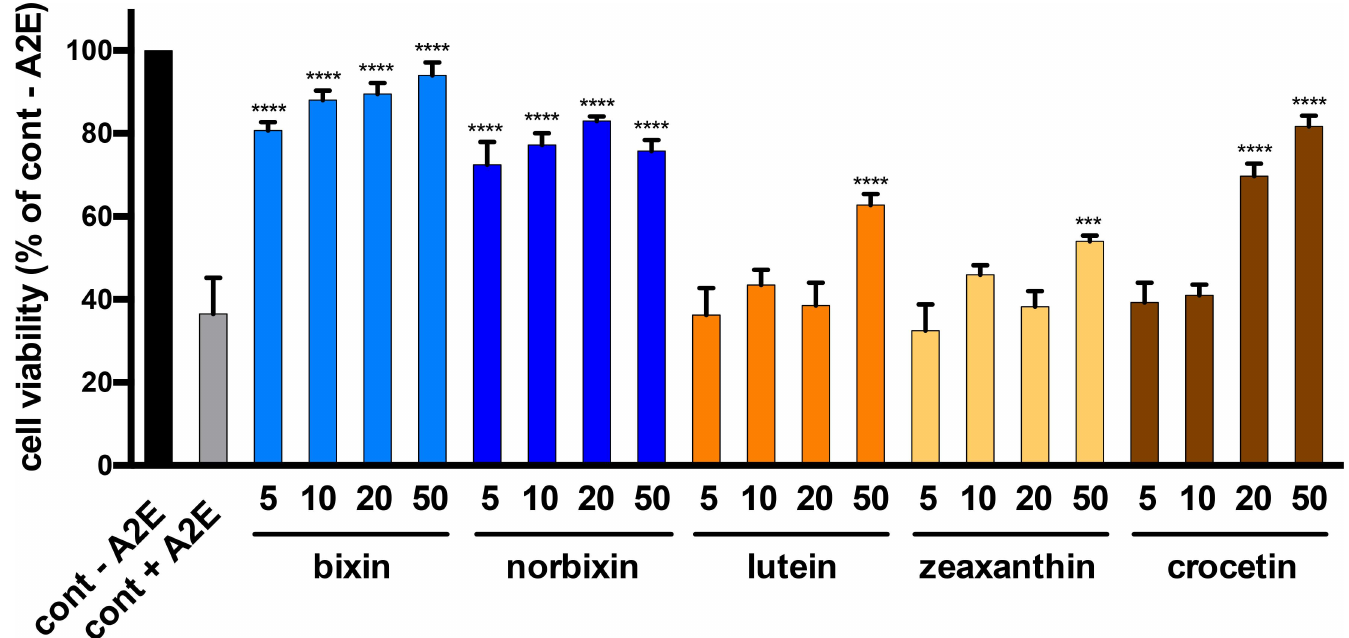
Fig 3. Dose-dependent effect of bixin, norbixin, lutein, zeaxanthin and crocetin on RPE cell survival after A2E-induced blue-light phototoxicity. Moleculeswere tested as describedin Fig 2A. The concentrations of the substances are in μ M. The positive control (cont–A2E) represents cells treated with DMSO alone. The negative control (cont + A2E) represents cells treated with A2E, but not with substances. Bars represent mean +/- s.e.m. of five independentexperiments with n = 4. *** p < 0.001; **** p < 0.0001 comparedto cont + A2E (One-way ANOVA, Dunnett’spost